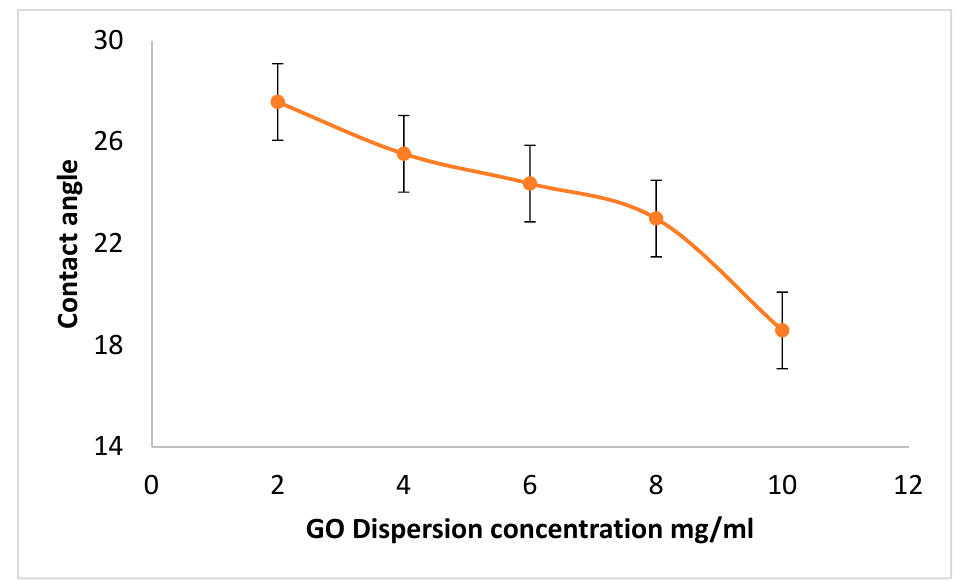
Figure 2. Contact angle of a water droplet on COC wafer coated with di ff erent concentrations of GO dispersion.